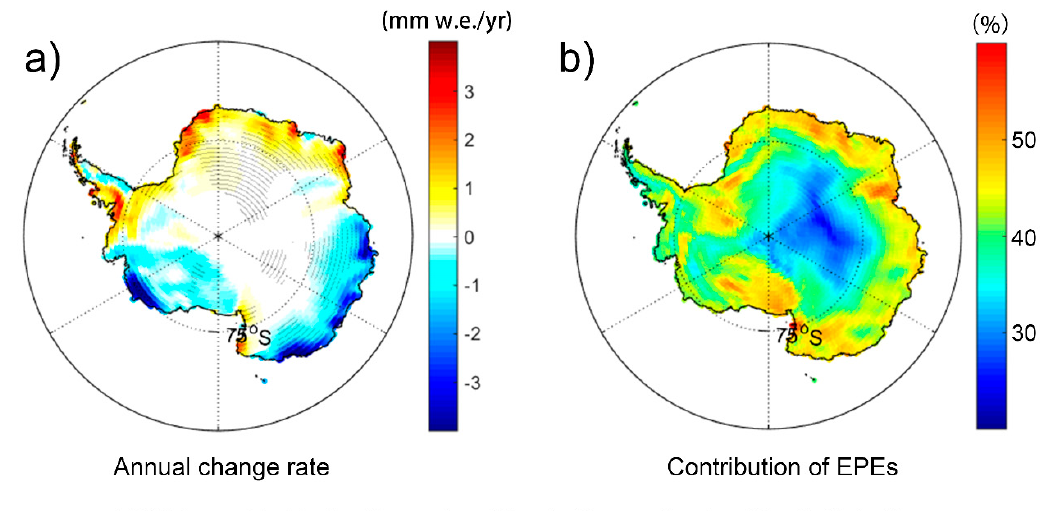
Figure 6. ( a ) Change rates in annual snowfall (mm w. e. year − 1 ) over the AIS from 1979 to 2018. The regions marked with dots are at the 90% significance level. Positive values indicate that there were increases in the annual snowfall. ( b ) Contribution of EPEs to the annual snowfall (%) over the AIS. Different colors indicate the percentage of annual snowfall coming from EPEs in each grid.